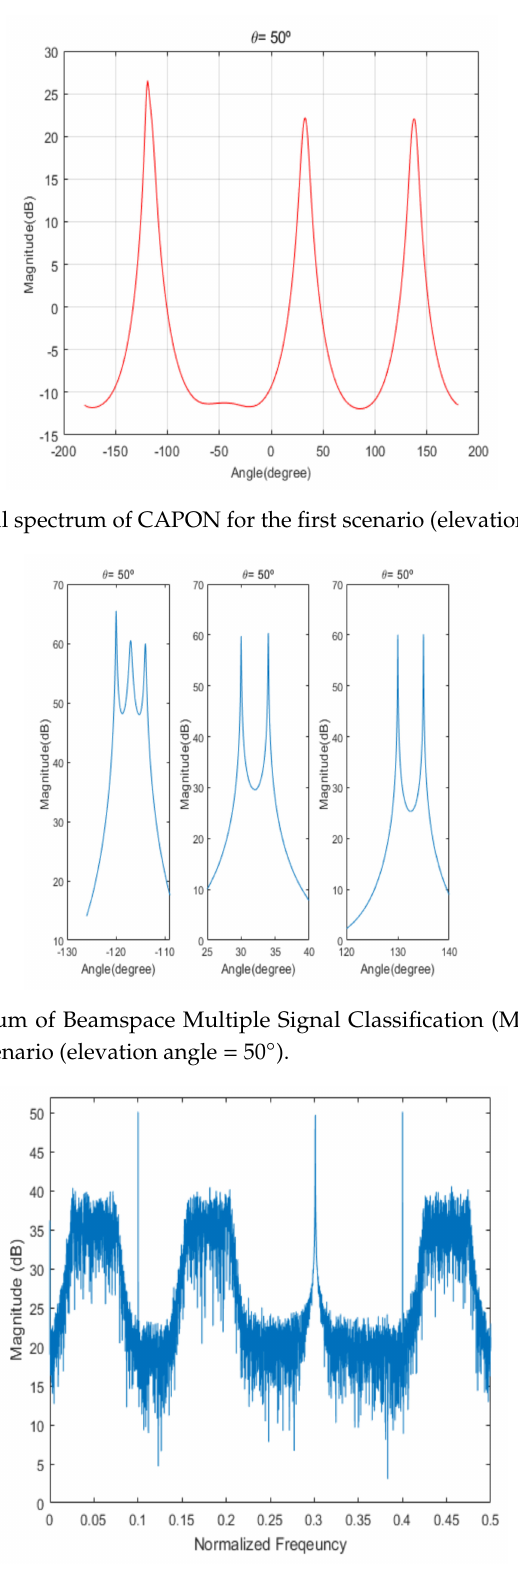
Figure 7. Spectrum of the received signal for the second